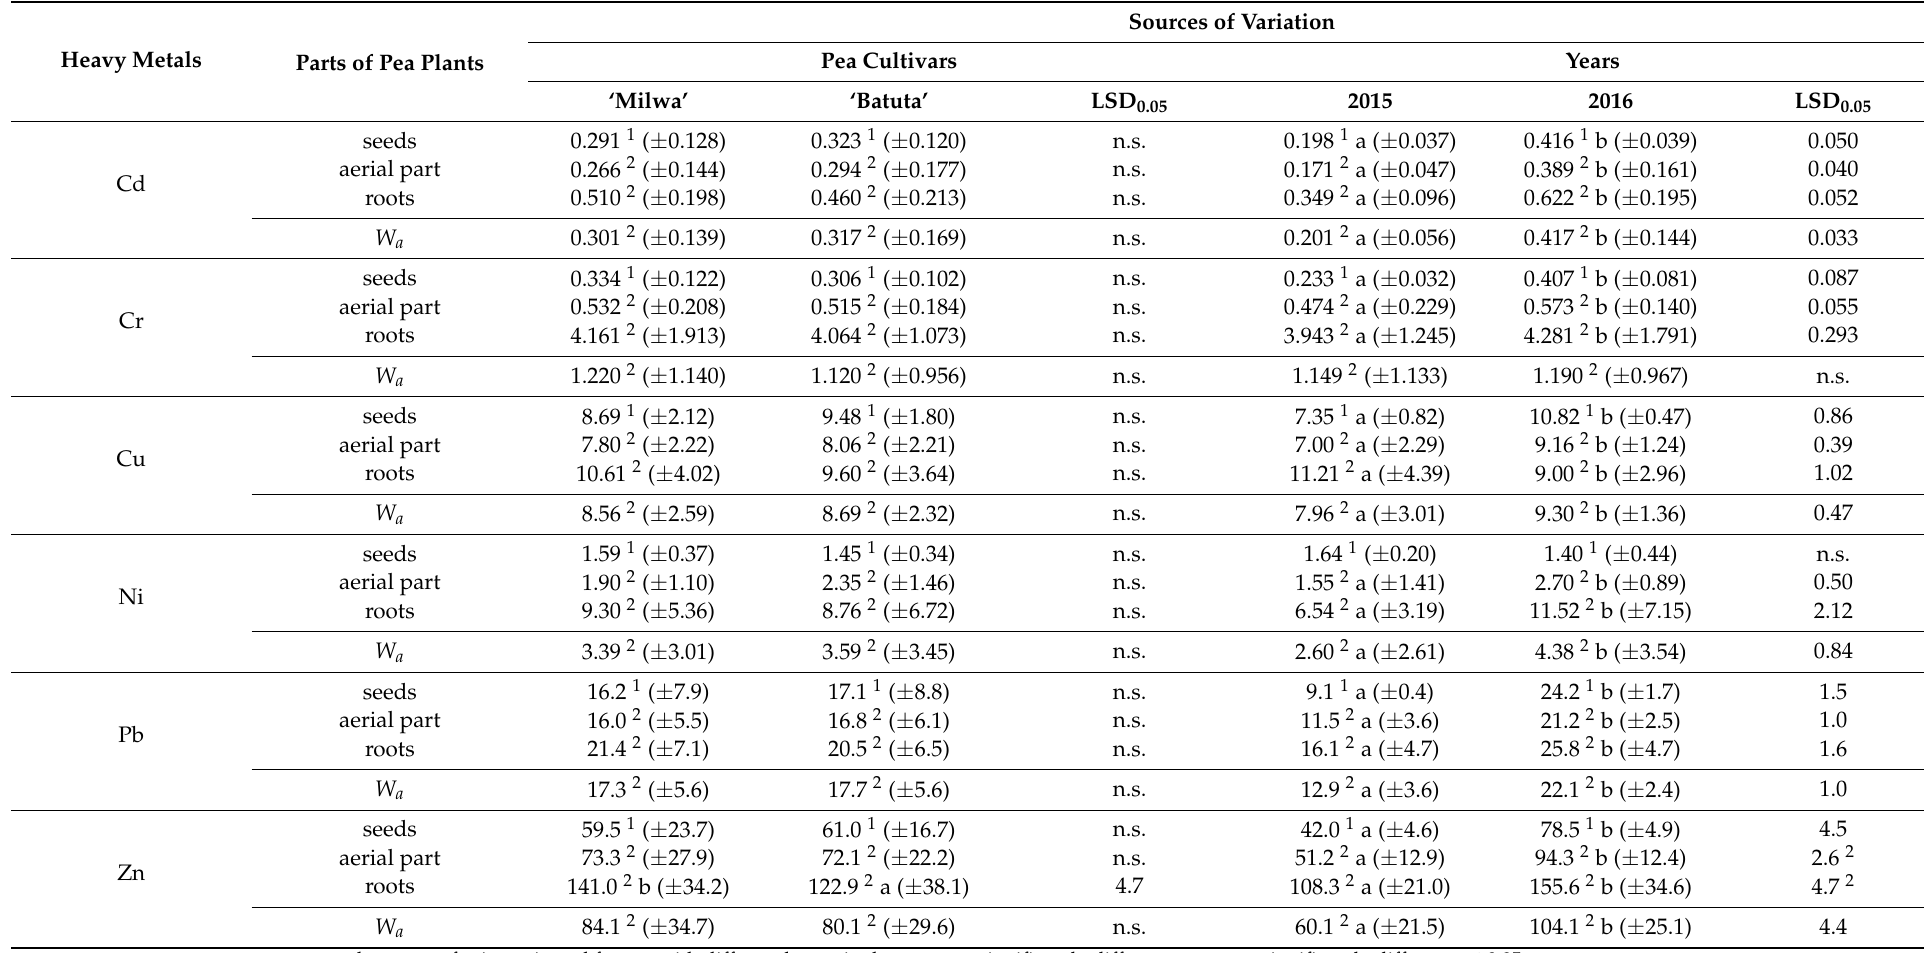
Table 4. Heavy metal content in different pea plants cultivars and years, mg · kg − 1 DW ( 1 mean values in maturity ± SD of two successive years or two cultivars, respectively, and with three repetitions each; 2 mean values ± SD of six growth stages, two successive years, or two cultivars, respectively, and with three repetitions